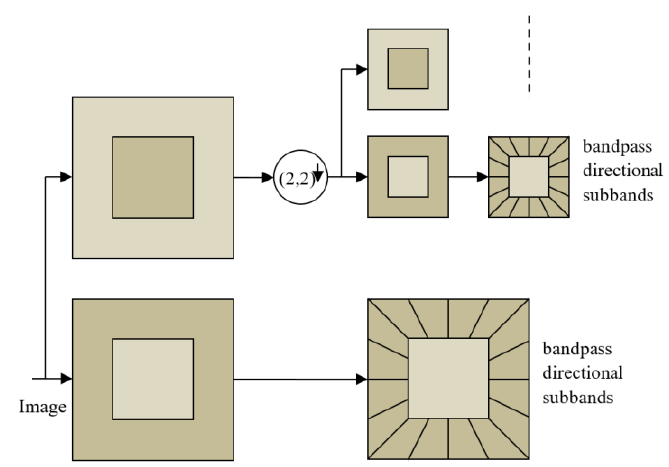
Figure 1. Contourlet transform decomposition structure (adapted from [24]).